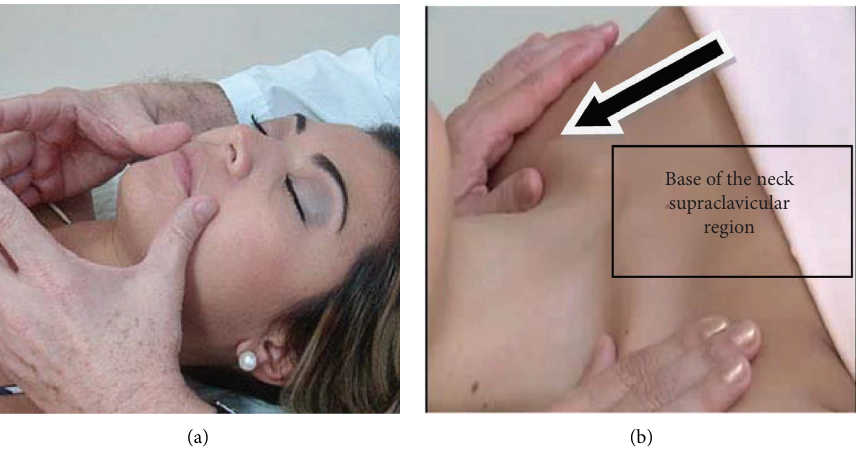
Figure 1: (a) Facial lymphatic drainage (linear movements) and (b) cervical lymphatic therapy Godoy method ®